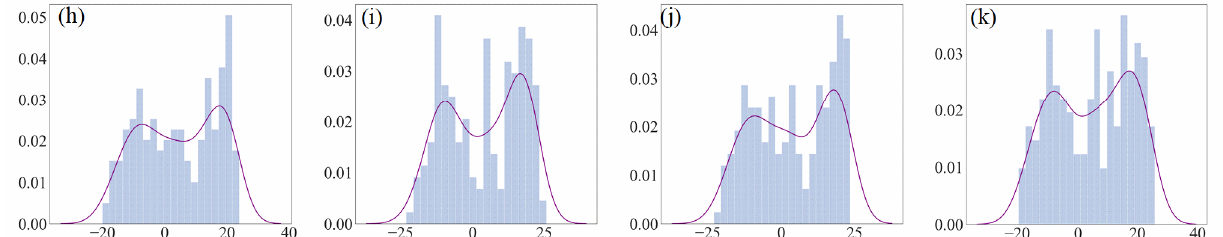
Figure A1. Changes in PDF during the successive adjustments of monthly air temperature based on the GCM MPI simulations at the Naqu site. The upper row indicates the control observations (( a ), 1955–1969)) and the calibrated results of the three adjustments ( b – d ). The center row ( e – g ) indicates the observations for validating the calibrated results for the corresponding projection periods. The bottom row ( h – k ) indicates the raw GCM simulations in the corresponding periods. The first column: control period (1955–1969); the second to fourth columns: the first (1970–1984), second (1985–1999) and third (2000–2014) adjustments, respectively. The solid line indicates a distribution fit to the data.